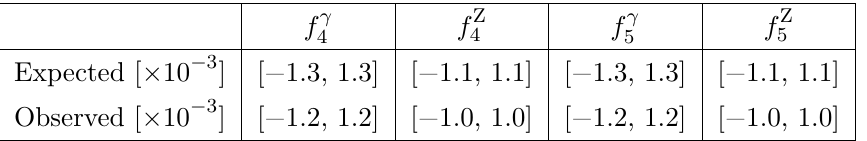
Table 10 . One-dimensional 95% con(cid:12)dence intervals for the aTGC parameters described in the text. The limits on each parameter are derived with the other parameters set to